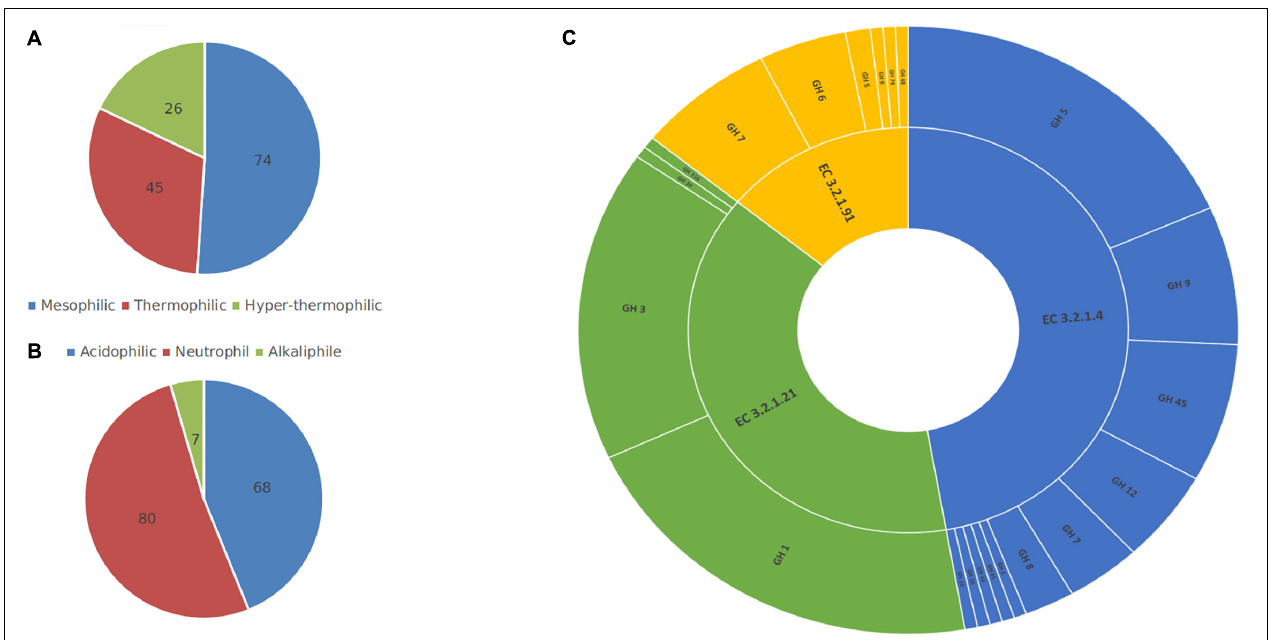
FIGURE 1 | Samples in temperature (A) and pH (B) datasets were divided into three classes based on their reported optima. The non-redundant union (C) of both datasets, had 163 instances with 3 different EC numbers and from 16 different glycoside hydrolase (GH) families. This figure shows the composition of each class or family in the collected